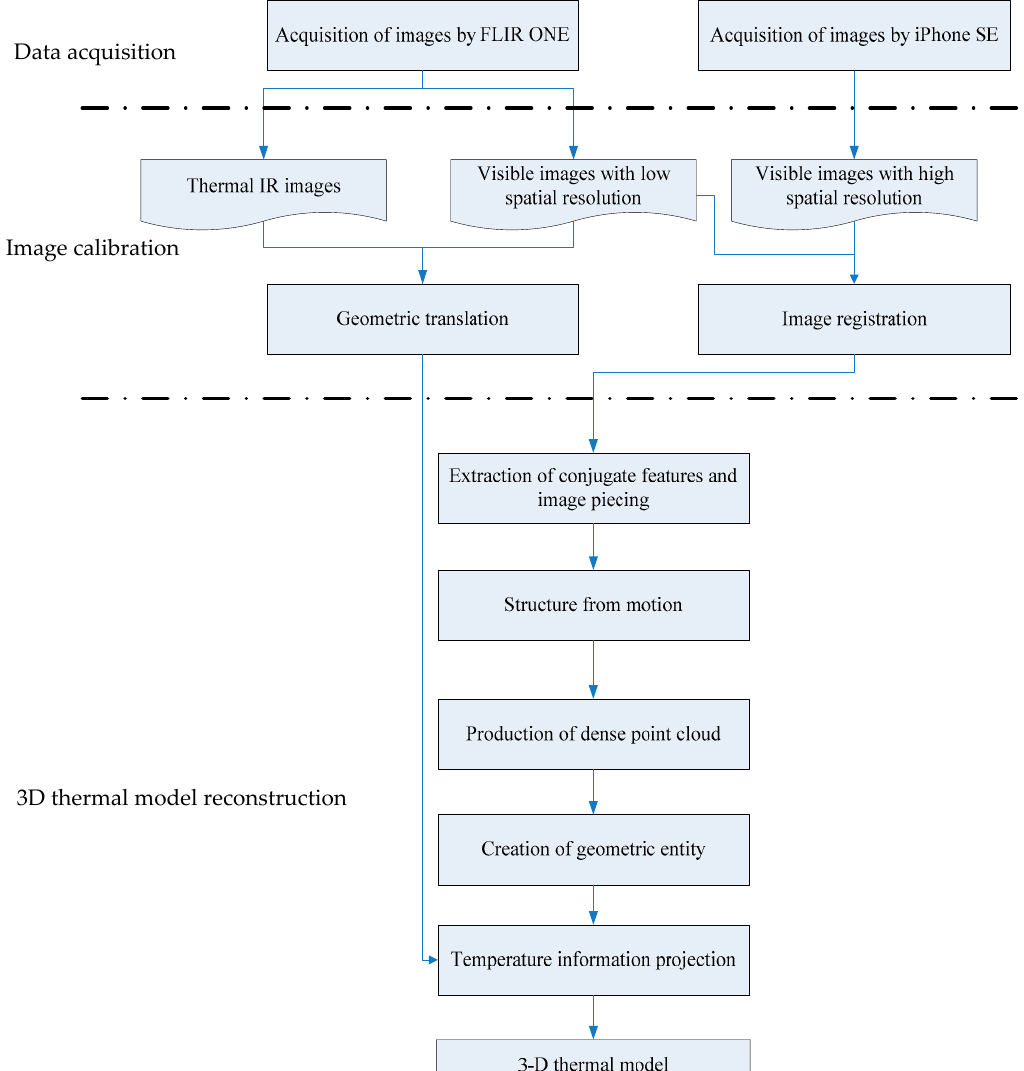
Figure 2. Scheme of proposed method for 3D thermal model reconstruction.